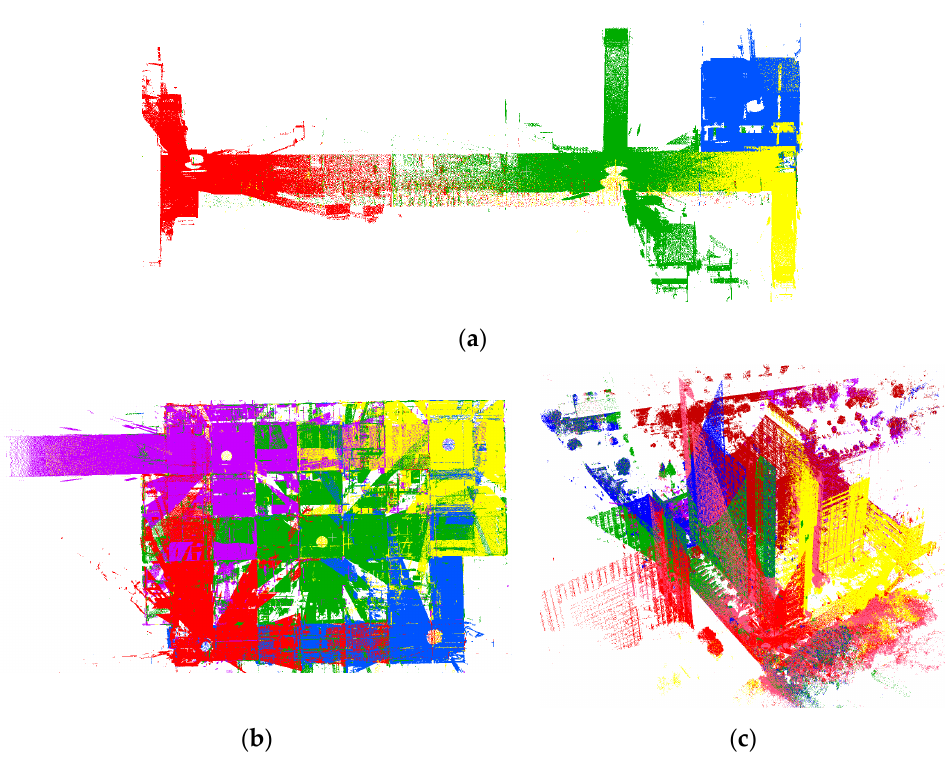
Figure 14. Overview of the reference data. All scans are rendered by different colors. ( a ) Dataset 1; ( b ) dataset 2; ( c ) dataset 3.